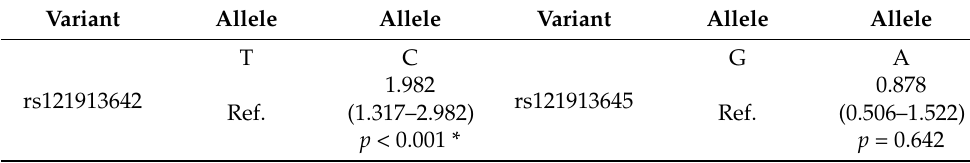
Table 5. Regression analysis of MYH7 rs121913642 and rs121913645 for disease risk. Variant Allele Allele Variant Allele